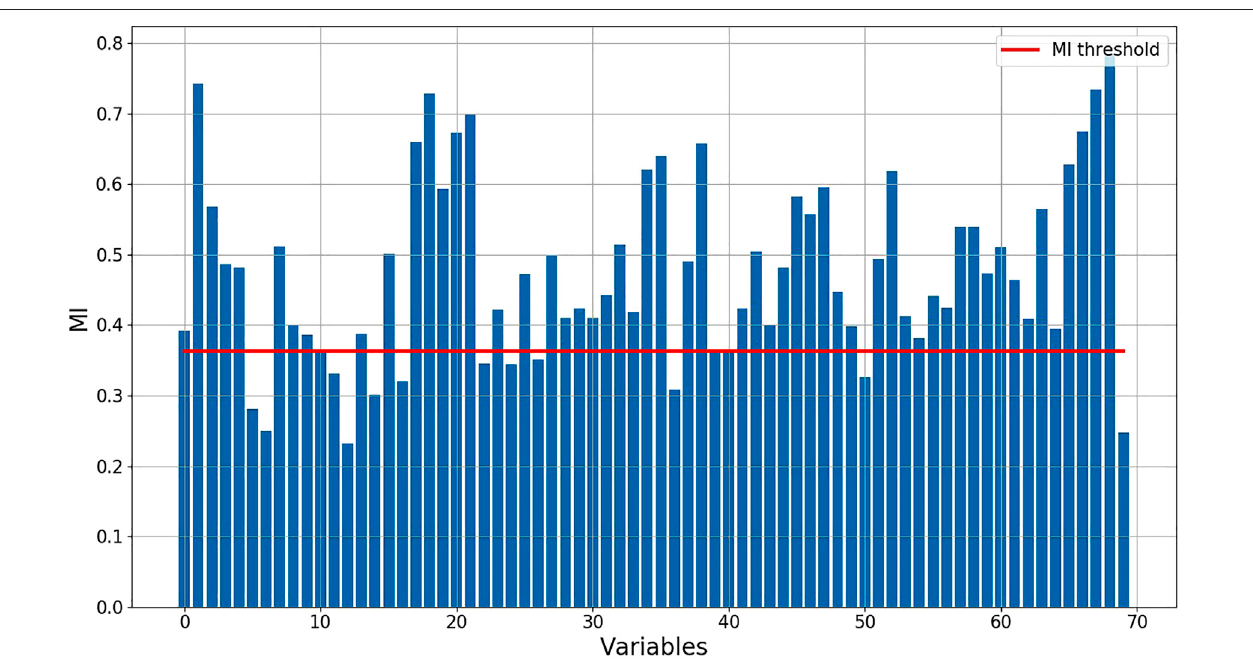
FIGURE 3 | MI of each independent variable with the dependent variable and the value of the threshold.